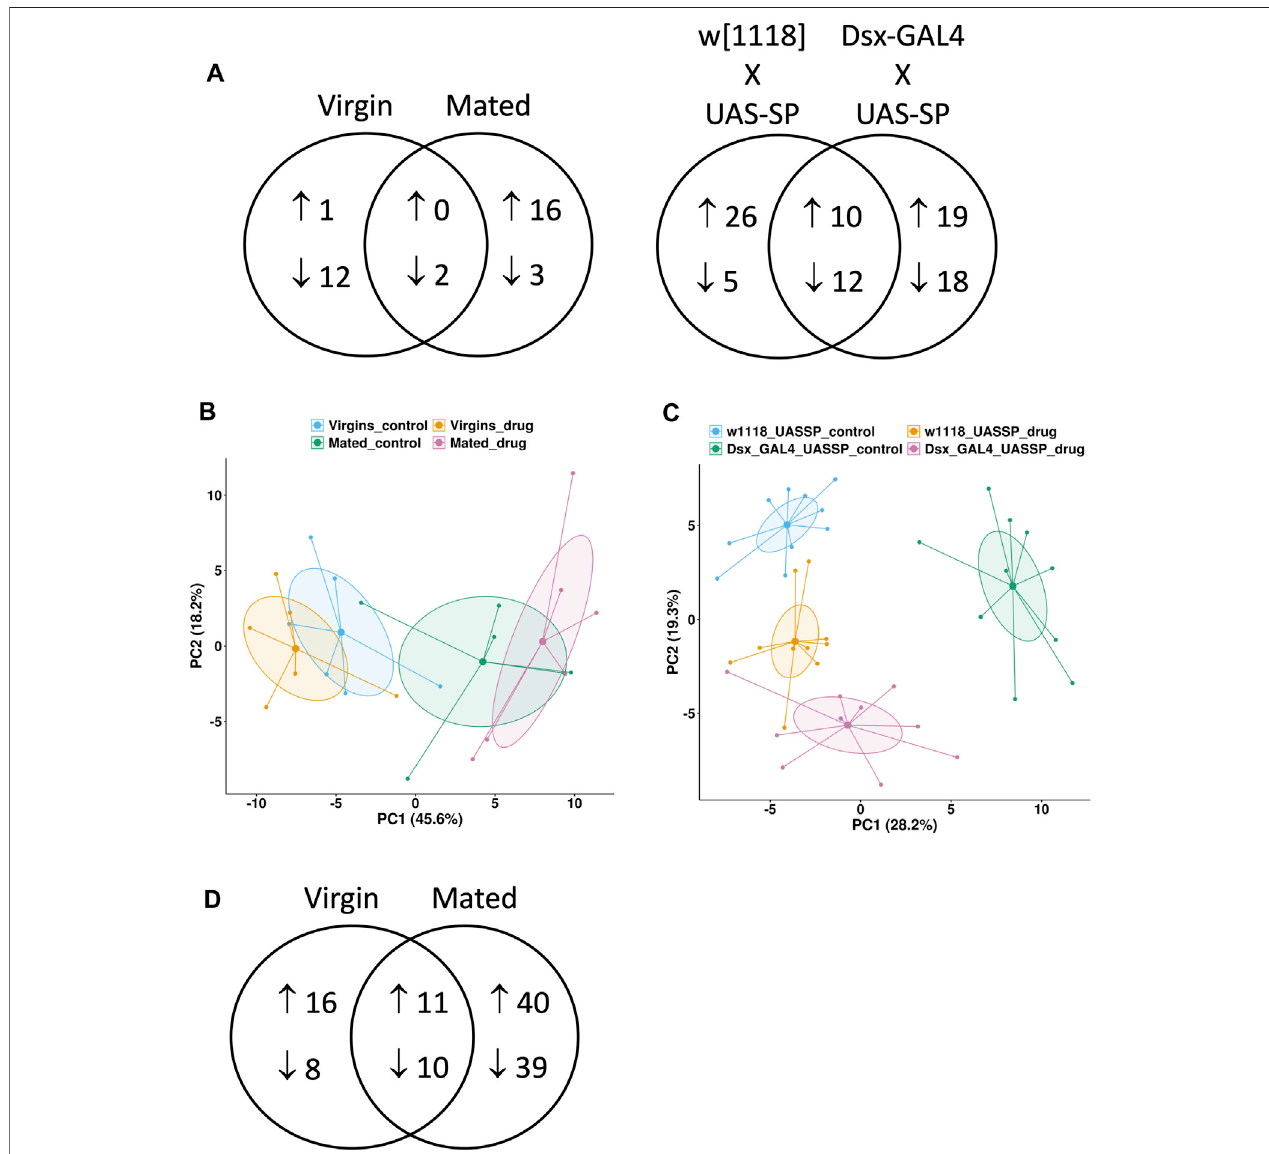
FIGURE4| Metabolomicsandtranscriptomicscomparisons.Targetedmetabolomicsassaywasconductedinthepresenceandabsenceof12 daysmifepristone treatment for several types of fl ies. Virgin females “ Virgin ” and mated females “ Mated ” were progeny of cross w[1118] x yw; Elav-GS . Also assayed were virgin female progeny of two additional crosses: “ w[1118] x UAS-SP ” is the negative control for transgenic expression of SP, and “ Dsx-GAL4 x UAS-SP ” results in constitutive transgenic expression of SP. (A) Venn diagram showing metabolites increased and decreased by mifepristone for each type of fl y. (B , C) Principal component analysis(PCA) plotsofmetabolite changescausedbymifepristone.Groupsareindicatedbycoloredpoints and95%con fi denceellipsesaroundeachgroupmeanpoint at the center. The percentage of the variance explained by each PC is shown in parentheses. (B) PCA plot of “ Virgin ” females in absence (blue) and presence (yellow) of mifepristone, and “ Mated ” females in absence (green) and presence (pink) of mifepristone. (C) PCA plot of “ w[1118] x UAS-SP ” females in absence (blue) and presence (yellow) of mifepristone, and “ Dsx-GAL4 x UAS-SP ” females in absence (green) and presence (pink) of mifepristone. (D) Venn diagram showing genes increased and decreased by mifepristone in virgin and mated